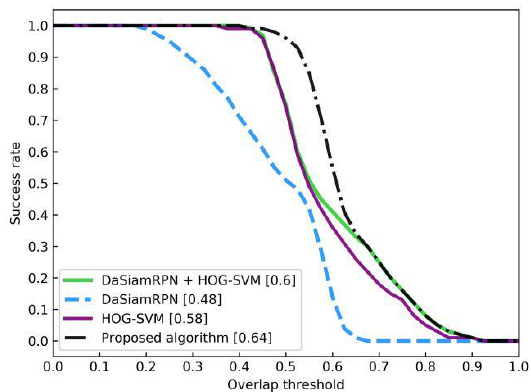
Figure 11. The success plots of Video Sequence I. Table 1. Comparison of the tracking speed (fps) and area under the curve (AUC) with different trackers.